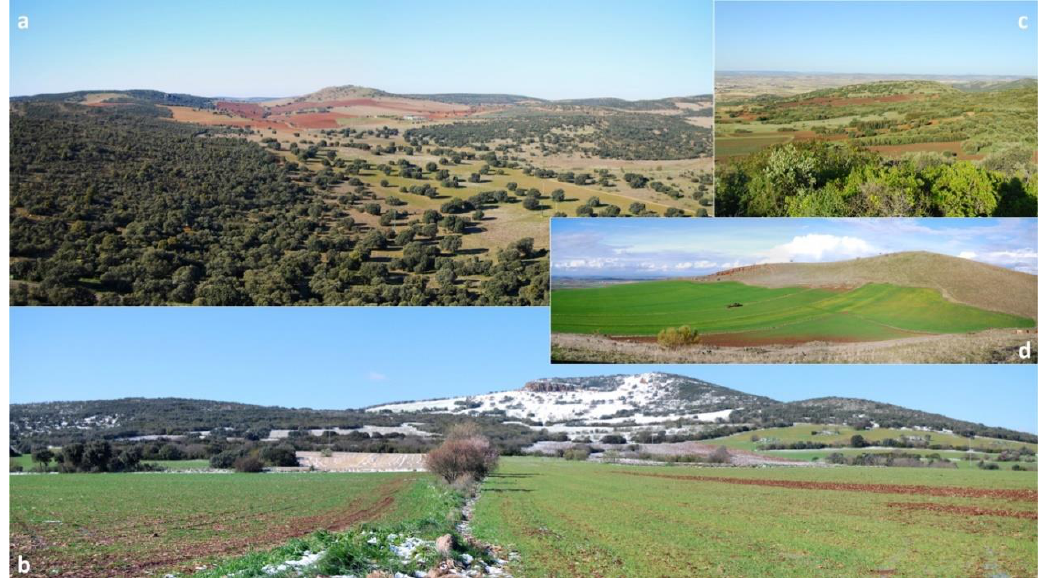
Figure 10. ( a ) Cerro Pelado volcano in the Calatrava massif surrounded by Mediterranean forest and meadows; ( b ) Peñarroya volcano Natural Monument in Sierra de Las Medias Lunas after a snowfall; ( c ) Cerro Prieto volcano at the top of Sierra de Calatrava; ( d ) rural landscape at the Cuevas Negras volcano.